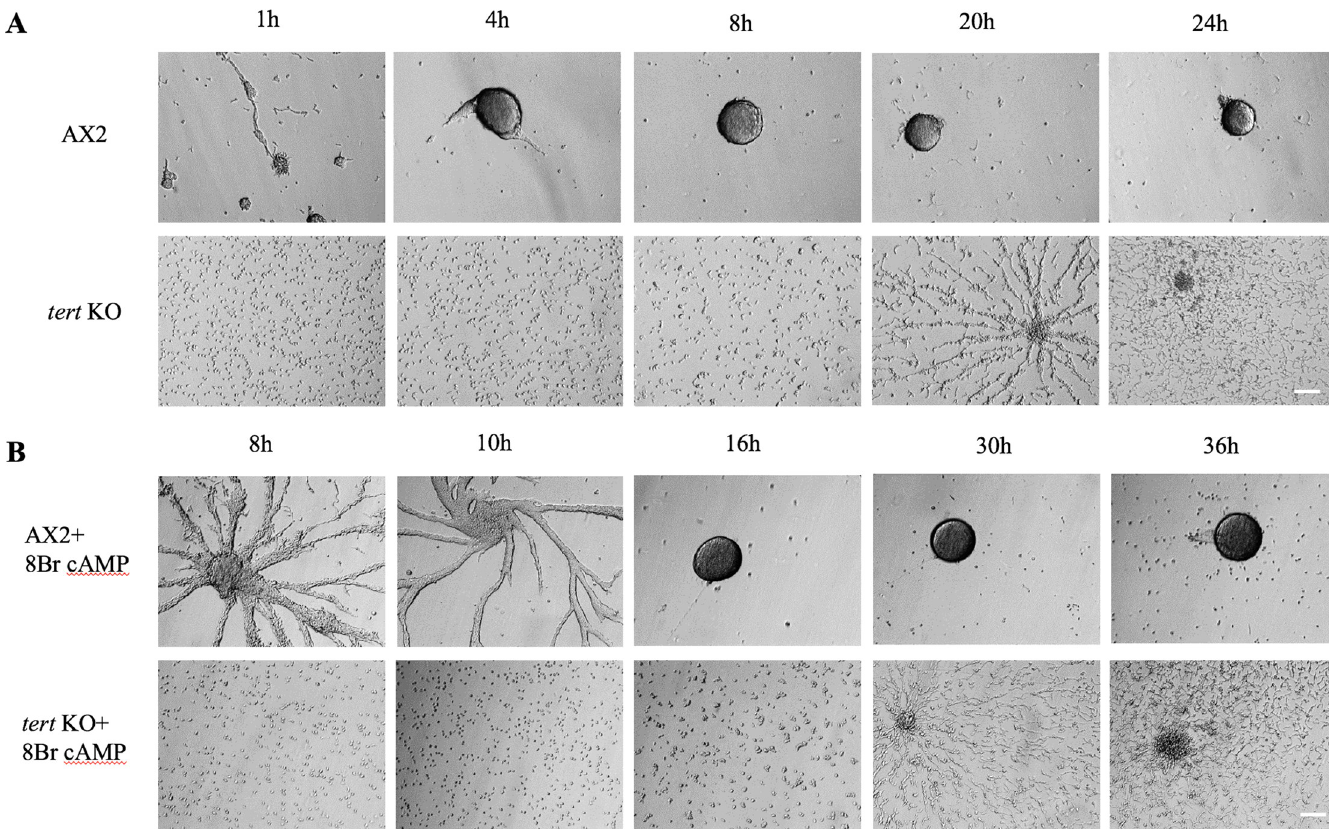
Fig 12. cAMP sensing in tert KO. (A) Wild-type and tert KO cells were starved for 1 hour and pulsed every 6 min with 50 nM cAMP for 4 h. Cells were then resuspended in BSS buffer and seeded at a density of 1x10 5 cells/ml, and observed under a microscope. (B) Wild-type and tert KO cells were washed in BSS buffer, seeded at a density of 1x10 5 cells/ ml, and incubated in BSS or BSS + 5 mM 8-Br-cAMP for 5 h. Cells were washed and then observed under a microscope. Scale bar: 100 μ m; (n =